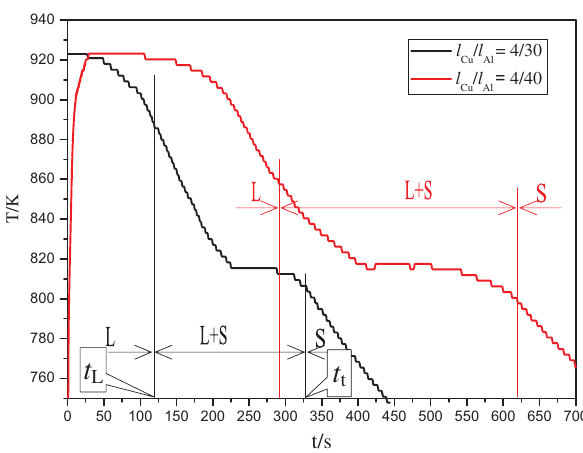
Figure 6: Cooling curves of contact positions of copper plate and liquid aluminum L – liquid phase; L + S – solid liquid two-phase; S – solid phase; t L – time remaining the single liquid phase; t – time to the end of t